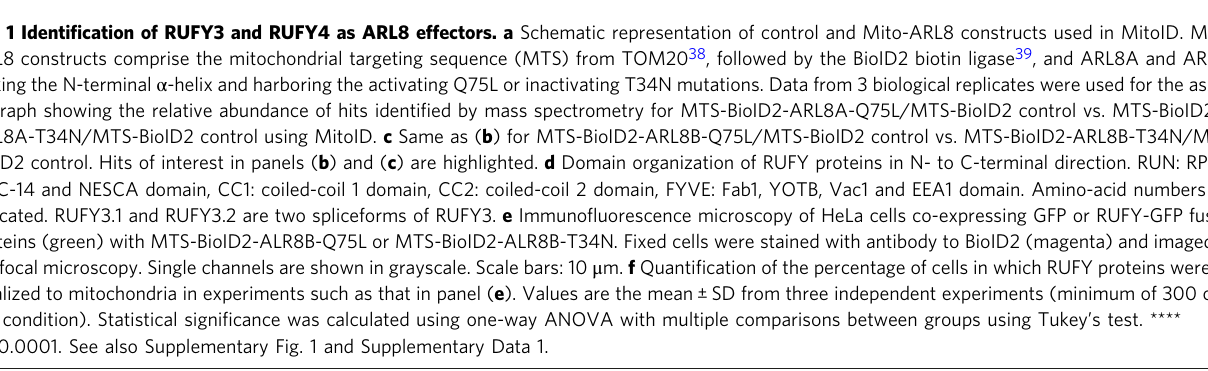
Fig. 1 Identi fi cation of RUFY3 and RUFY4 as ARL8 effectors. a Schematic representation of control and Mito-ARL8 constructs used in MitoID. Mito- ARL8 constructs comprise the mitochondrial targeting sequence (MTS) from TOM20 38 , followed by the BioID2 biotin ligase 39 , and ARL8A and ARL8B lacking the N-terminal α -helix and harboring the activating Q75L or inactivating T34N mutations. Data from 3 biological replicates were used for the assay. b Graph showing the relative abundance of hits identi fi ed by mass spectrometry for MTS-BioID2-ARL8A-Q75L/MTS-BioID2 control vs. MTS-BioID2- ARL8A-T34N/MTS-BioID2 control using MitoID. c Same as ( b ) for MTS-BioID2-ARL8B-Q75L/MTS-BioID2 control vs. MTS-BioID2-ARL8B-T34N/MTS- BioID2 control. Hits of interest in panels ( b ) and ( c ) are highlighted. d Domain organization of RUFY proteins in N- to C-terminal direction. RUN: RPIP8, UNC-14 and NESCA domain, CC1: coiled-coil 1 domain, CC2: coiled-coil 2 domain, FYVE: Fab1, YOTB, Vac1 and EEA1 domain. Amino-acid numbers are indicated. RUFY3.1 and RUFY3.2 are two spliceforms of RUFY3. e Immuno fl uorescence microscopy of HeLa cells co-expressing GFP or RUFY-GFP fusion proteins (green) with MTS-BioID2-ALR8B-Q75L or MTS-BioID2-ALR8B-T34N. Fixed cells were stained with antibody to BioID2 (magenta) and imaged by confocal microscopy. Single channels are shown in grayscale. Scale bars: 10 μ m. f Quanti fi cation of the percentage of cells in which RUFY proteins were re- localized to mitochondria in experiments such as that in panel ( e ). Values are the mean ± SD from three independent experiments (minimum of 300 cells per condition). Statistical signi fi cance was calculated using one-way ANOVA with multiple comparisons between groups using Tukey ’ s test. **** p < 0.0001. See also Supplementary Fig. 1 and Supplementary Data